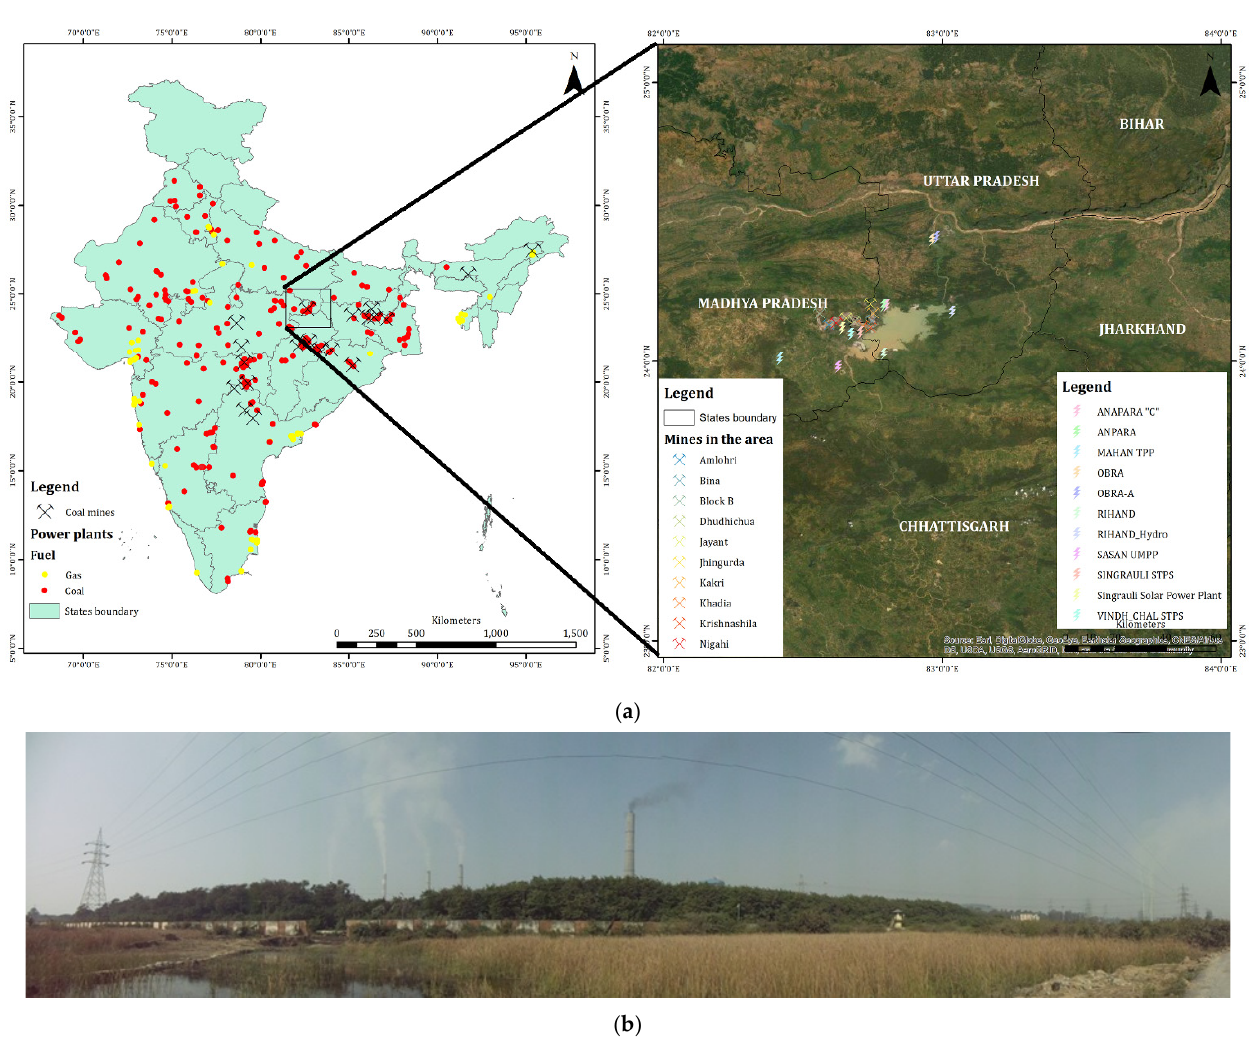
Figure 1. ( a ) Location of power plants (Gas and Coal) and coal mines in India ( Left ), Map of study area, Singrauli, with the location of thermal power plants and coal mines ( Right ). ( b ) Photo from Singrauli area where a number of coal-based power plants (see Table 1) and coal mines are located; all these activities impact the atmosphere and air quality in the areas (photo taken by Ramesh Singh). Table 1. Location of various TPPs in the study area showing installation date and further expansion months. These details are extracted from the individual website of the corporations that have in- stalled coal-based TPPs in the study area.